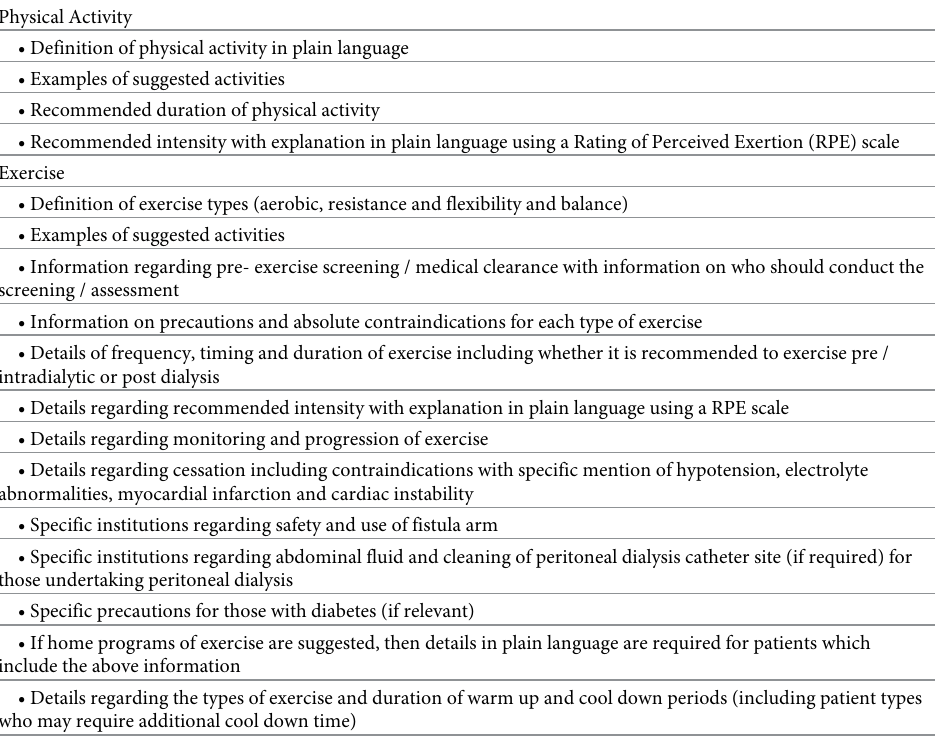
Table 5. Proposed checklist for reporting in physical activity and exercise guidelines for people undertaking